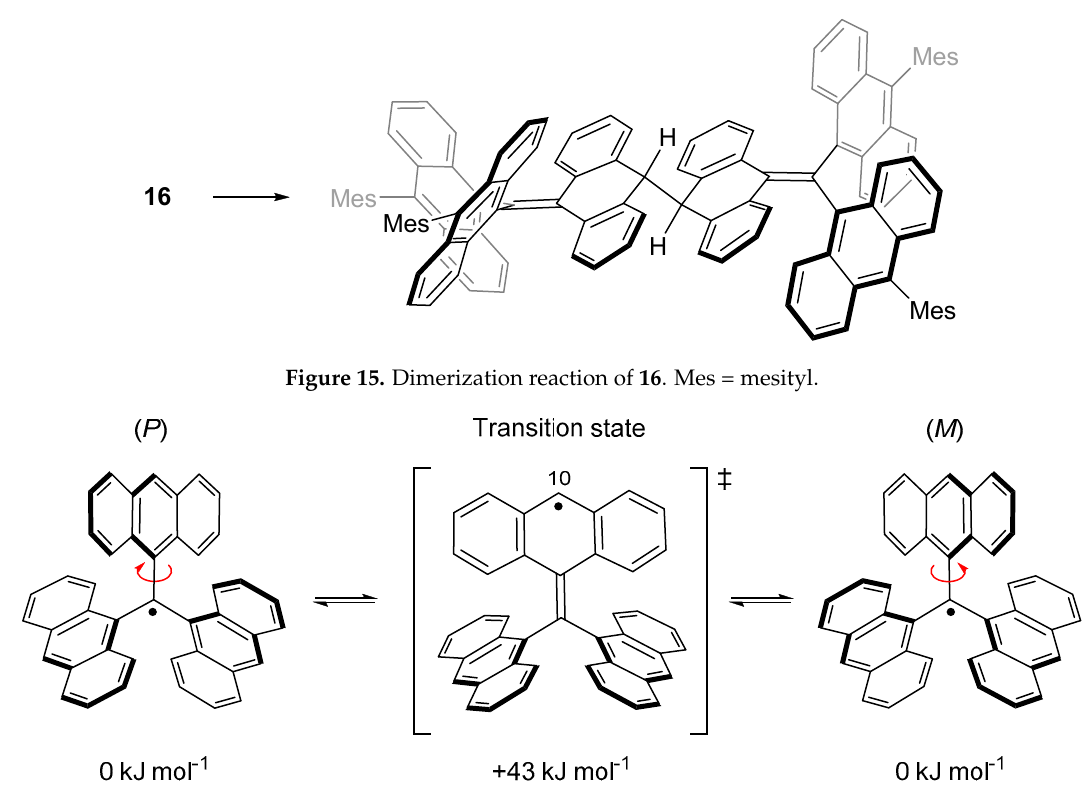
Figure 16. Relative energies for propeller flipping motion of 14 calculated at the U ω B97X-D/6-31G** level of theory.